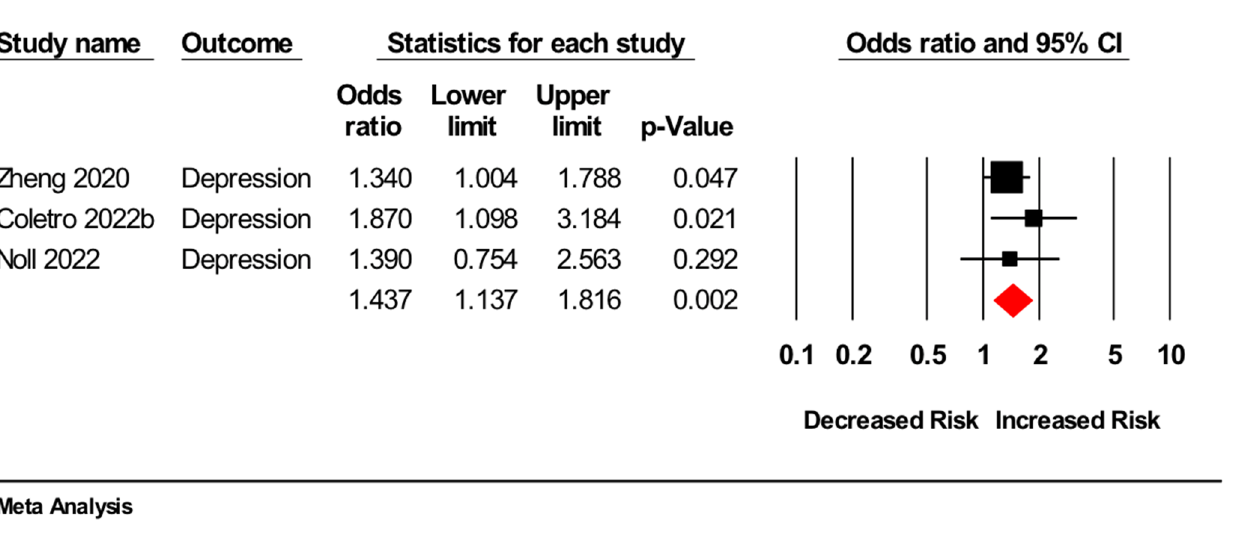
Figure 2. Forest plot of meta-analysis for cross-sectional studies assessing association between higher versus lower consumption of ultra-processed food and odds of depressive symptoms [19,21,24].